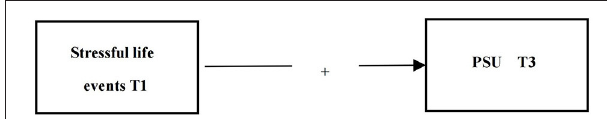
FIGURE 1 | Visualization of Hypothesis 1.